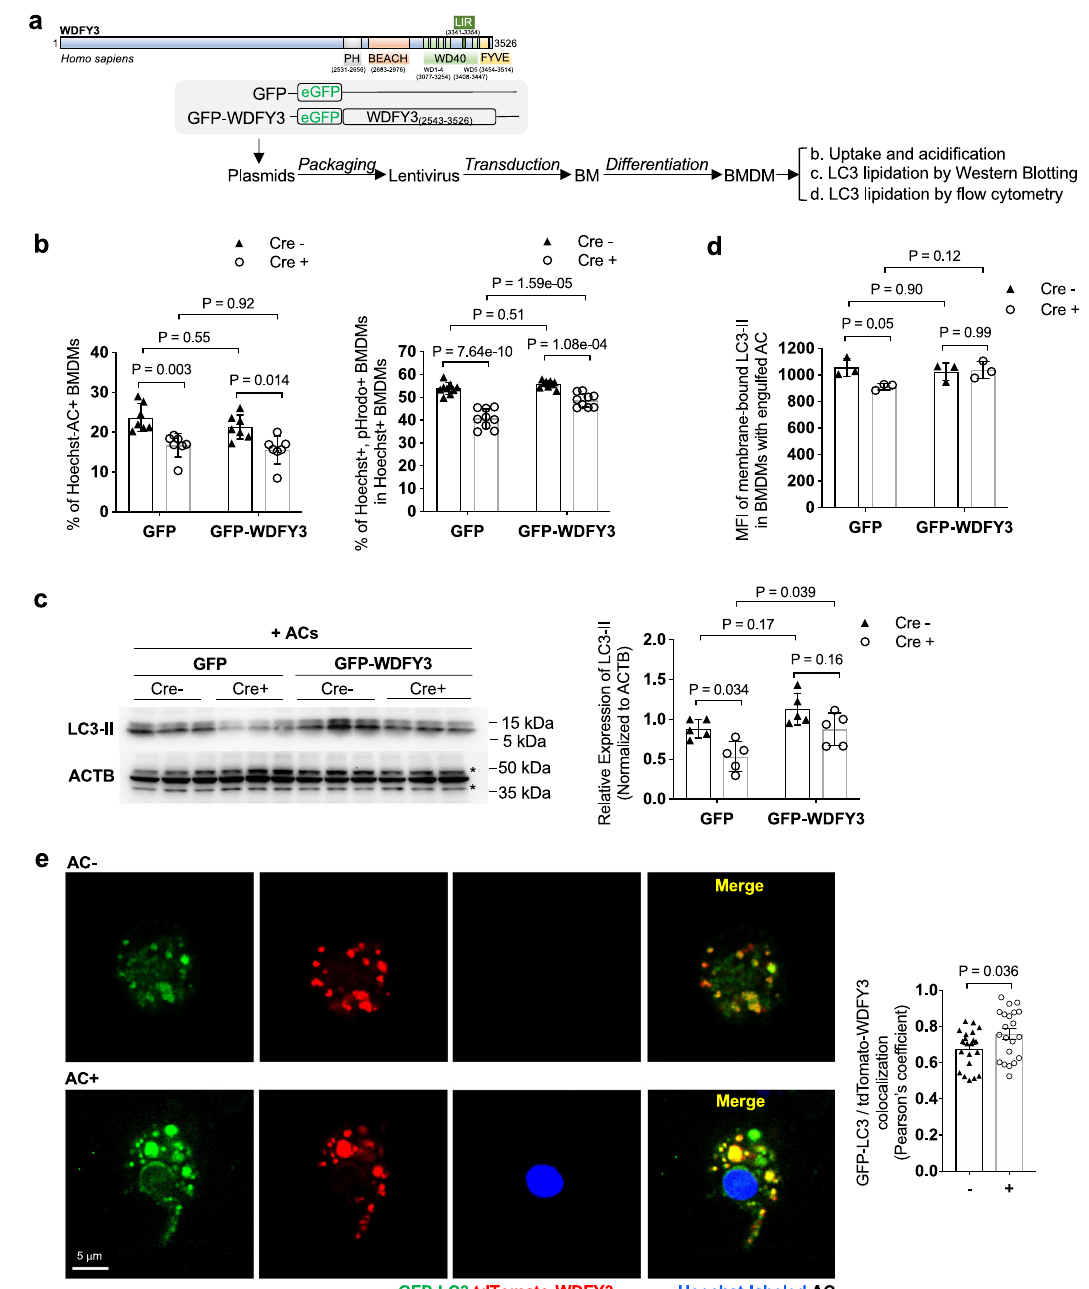
Fig. 4 | The C-terminal WDFY3 is suf fi cient for regulating degradation yet the full-length WDFY3 is required for the uptake of ACs during efferocytosis. a Schematics of lentiviral overexpression of C-terminal WDFY3 in BMDMs of Cre - and Cre + mice. b C-terminal WDFY3 did not restore uptake, yet partially rescued the defects in cargo acidi fi cation in Cre + mice ( n =7 biological replicates, each from the average of 2 technical replicates). c C-terminal WDFY3 restored LC3-II levels in Cre + mice as determined by western blot ( n =5 biological replicates. * indicates non-speci fi c bands) and in ( d ) by fl ow cytometry ( n =3 biological replicates). e BMDMs from GFP-LC3 mice were transfected with